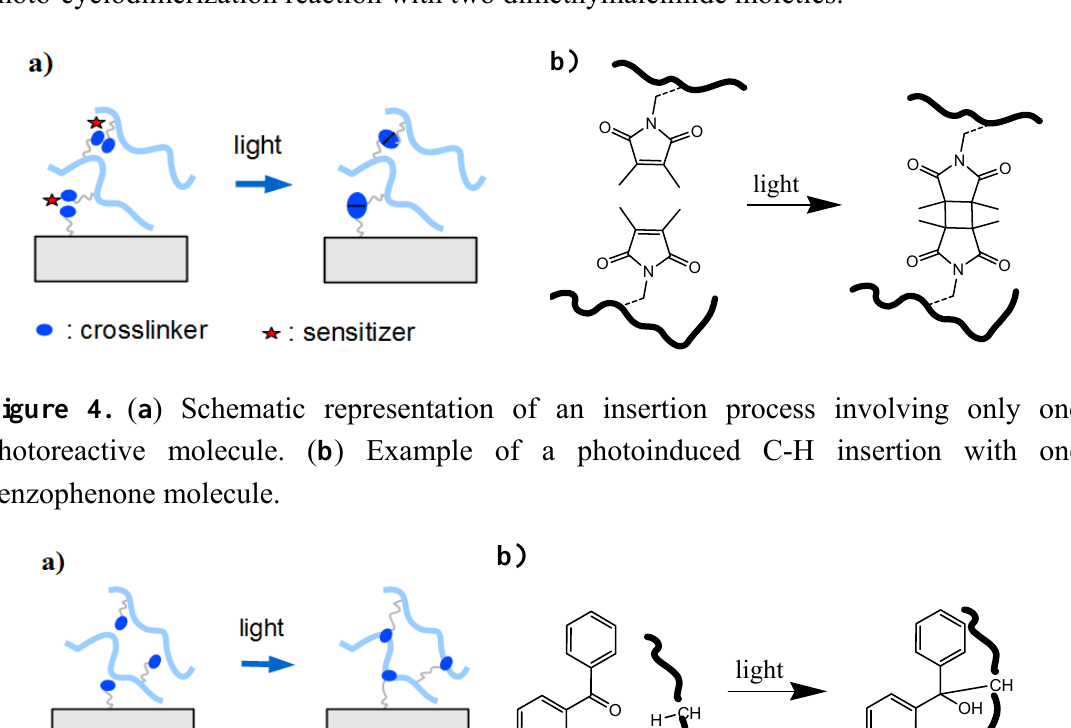
Figure 3. ( a ) Schematic representation of a dimerization process requiring two reactive units per crosslink point and potentially a sensitizer molecule. ( b ) Example of a [2+2] photo-cyclodimerization reaction with two dimethymaleimide moieties.